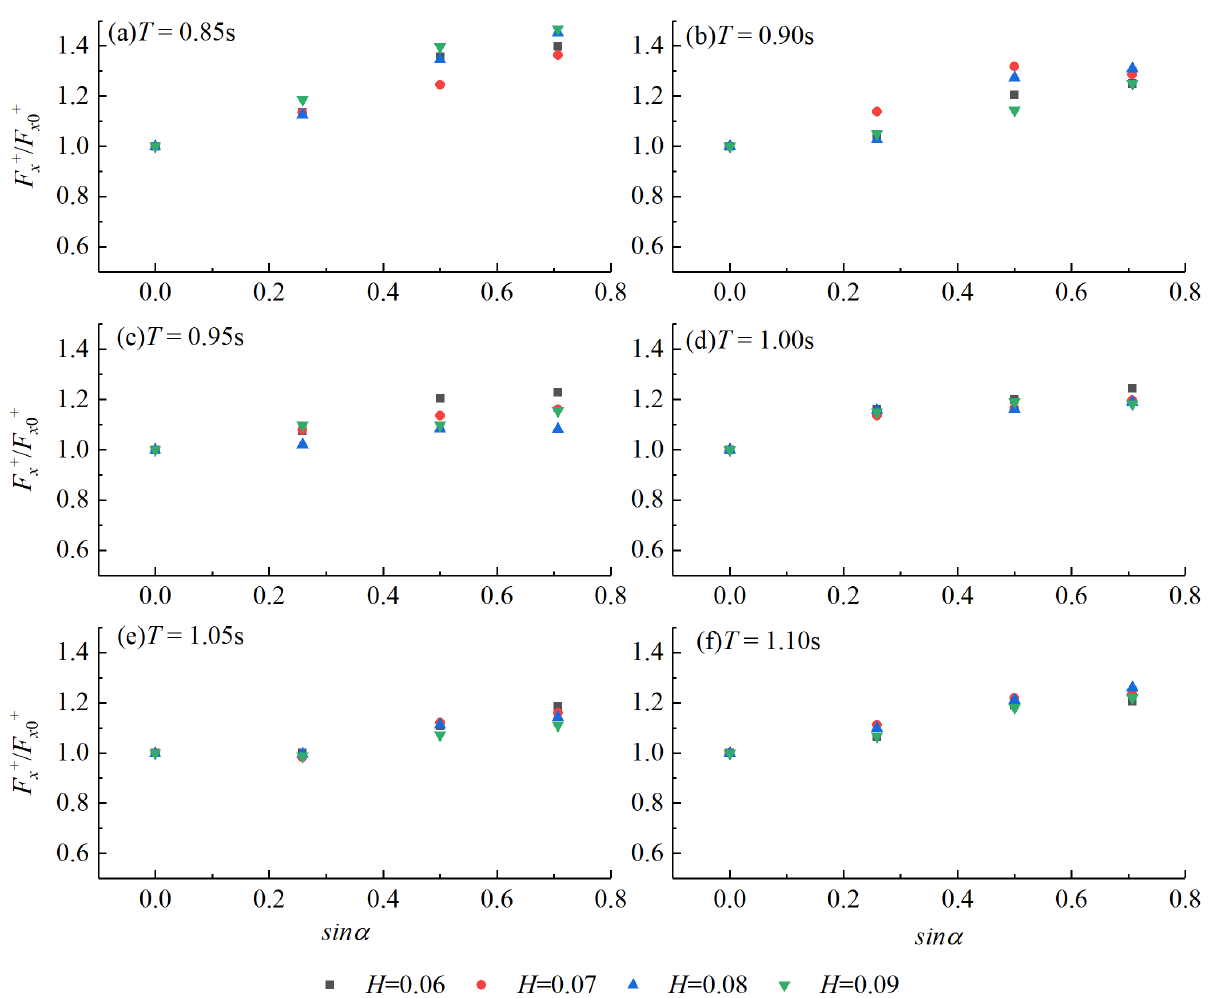
Figure 10. The wave directionality effect on the longitudinal positive peak force for the conditions of ( a ) T = 0.85 s, ( b ) T = 0.90 s, ( c ) T = 0.95 s, ( d ) T = 1.00 s, ( e ) T = 1.05 s, ( f ) T = 1.10 s.